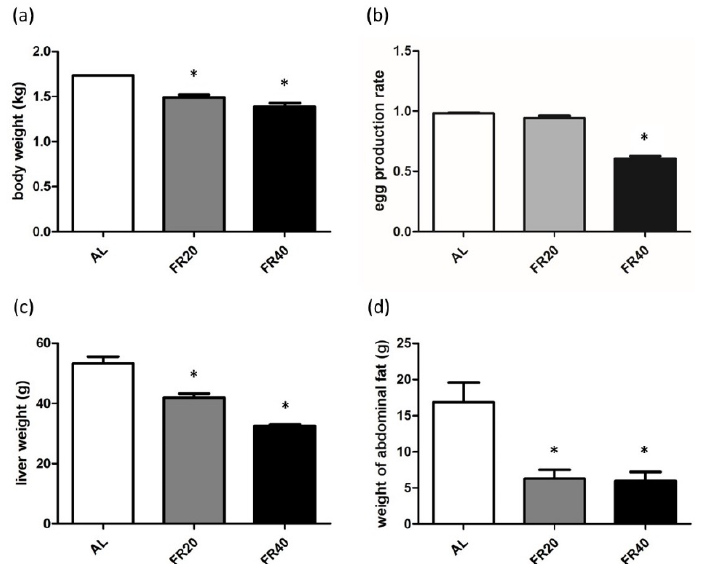
Figure 1. Effect of FR on production performance of laying hens: ( a ) body weight; ( b ) egg production; ( c ) liver weight; ( d ) abdominal fat between AL, FR20, and FR40 group. AL: ad libitum with basal diet; FR20: basal diet with 20% feed restriction; FR40: basal diet with 40% feed restriction. * p < 0.05 comparing data of FR20 or FR40 versus AL